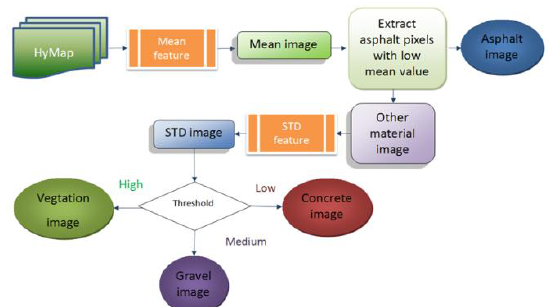
Figure 5. Classification using the brightness (mean and standard deviation) feature.